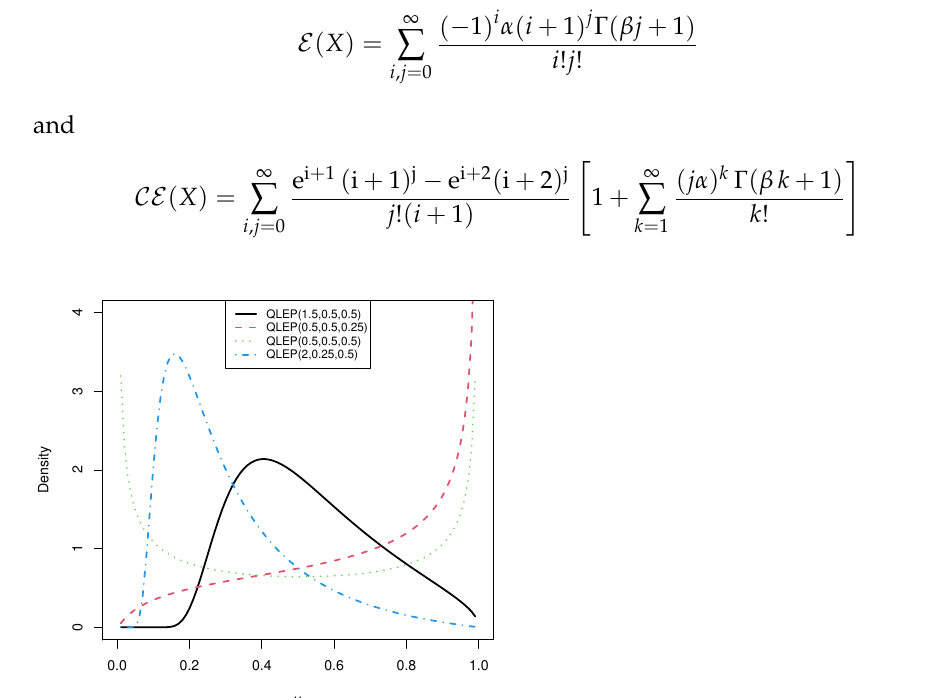
Figure 3. The pdf shapes of the QLEP